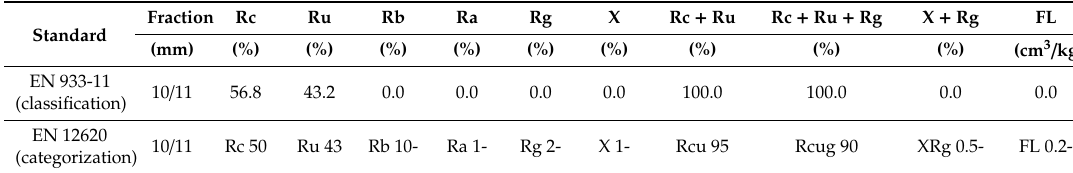
Table 2. Classification and categorisation of coarse RCA.